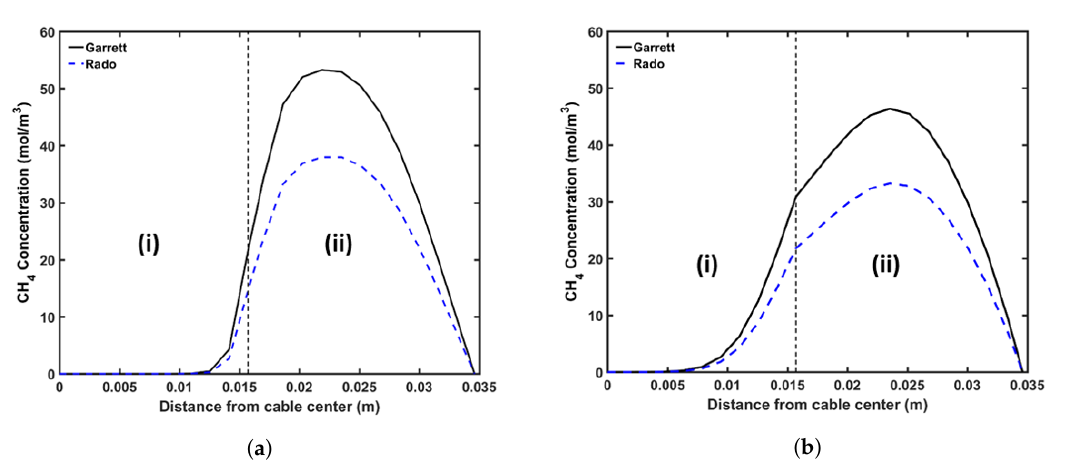
Figure 10. Radial CH 4 concentration profile at ( a ) curing tube exit, ( b ) cable take-up point. segment (i) corresponds to conductor layer while segment (ii) corresponds to XLPE and SC